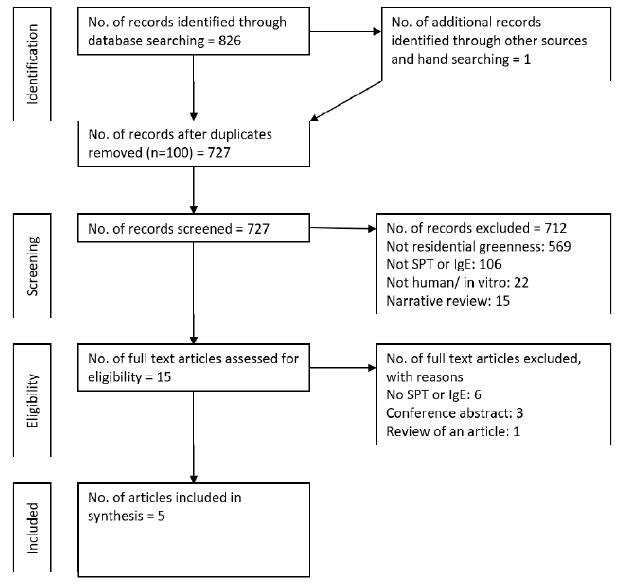
Figure 1. PRISMA flow diagram showing the progression of studies through the review.